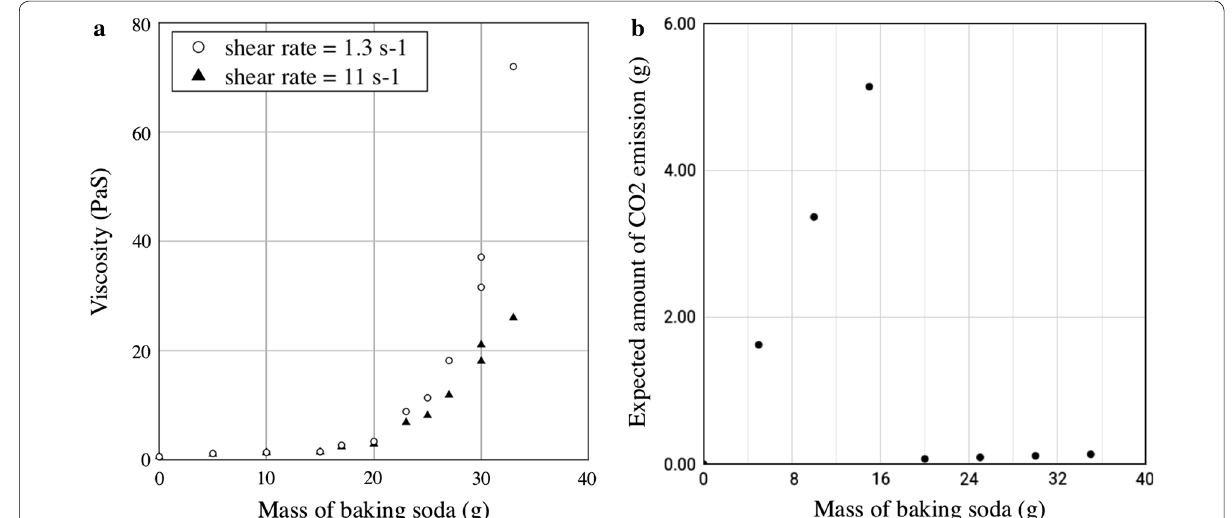
Fig. 4 a Rheological characteristics of substrates with various compositions. b Expected amount of CO 2 emission calculated from viscosity (shear rate: 1.3 s − 1 ) and concentration of baking soda. Details are given in the